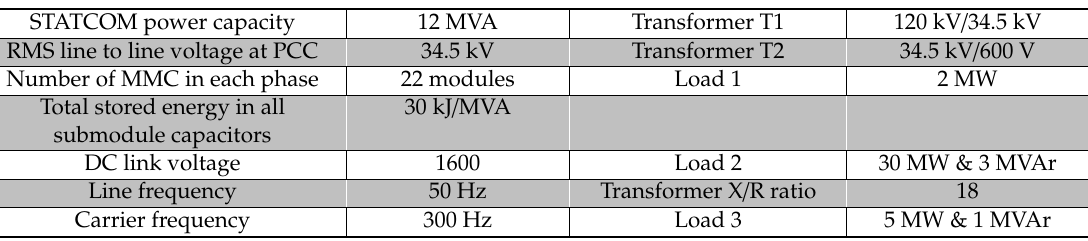
Figure 9. A model of the power system under study. Table 2. Parameters of the studied